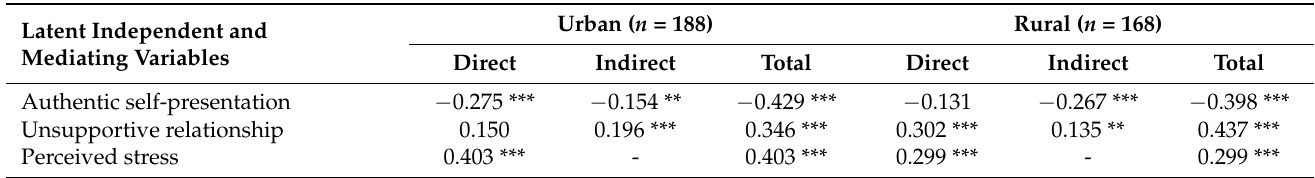
Table 5. Effects of latent independent and mediating